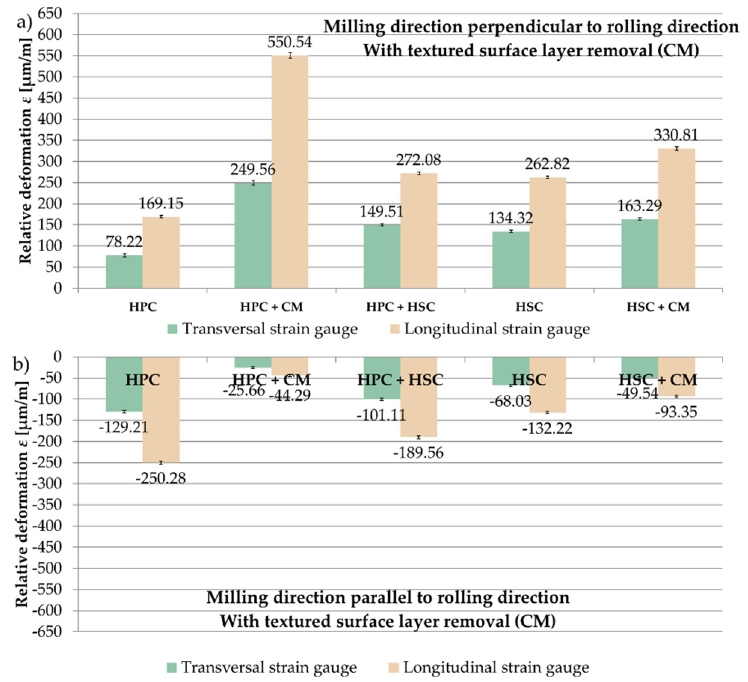
Figure 8. Relative deformation ε obtained for samples in which the textured surface layer (CM) was removed, the analysed cutting strategies and the relation of the milling direction to the rolling direction: ( a ) perpendicular, ( b ) parallel.